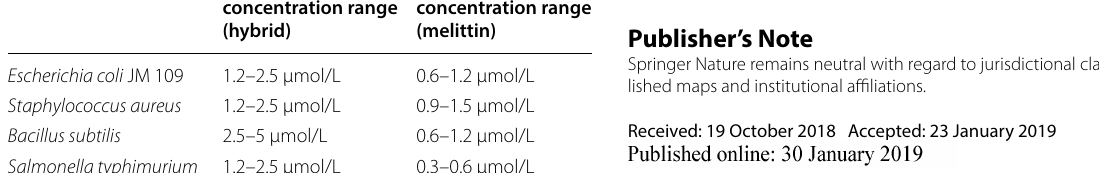
Table 2 Minimum inhibitory concentration (MIC) range of antimicrobial peptides Bacterial